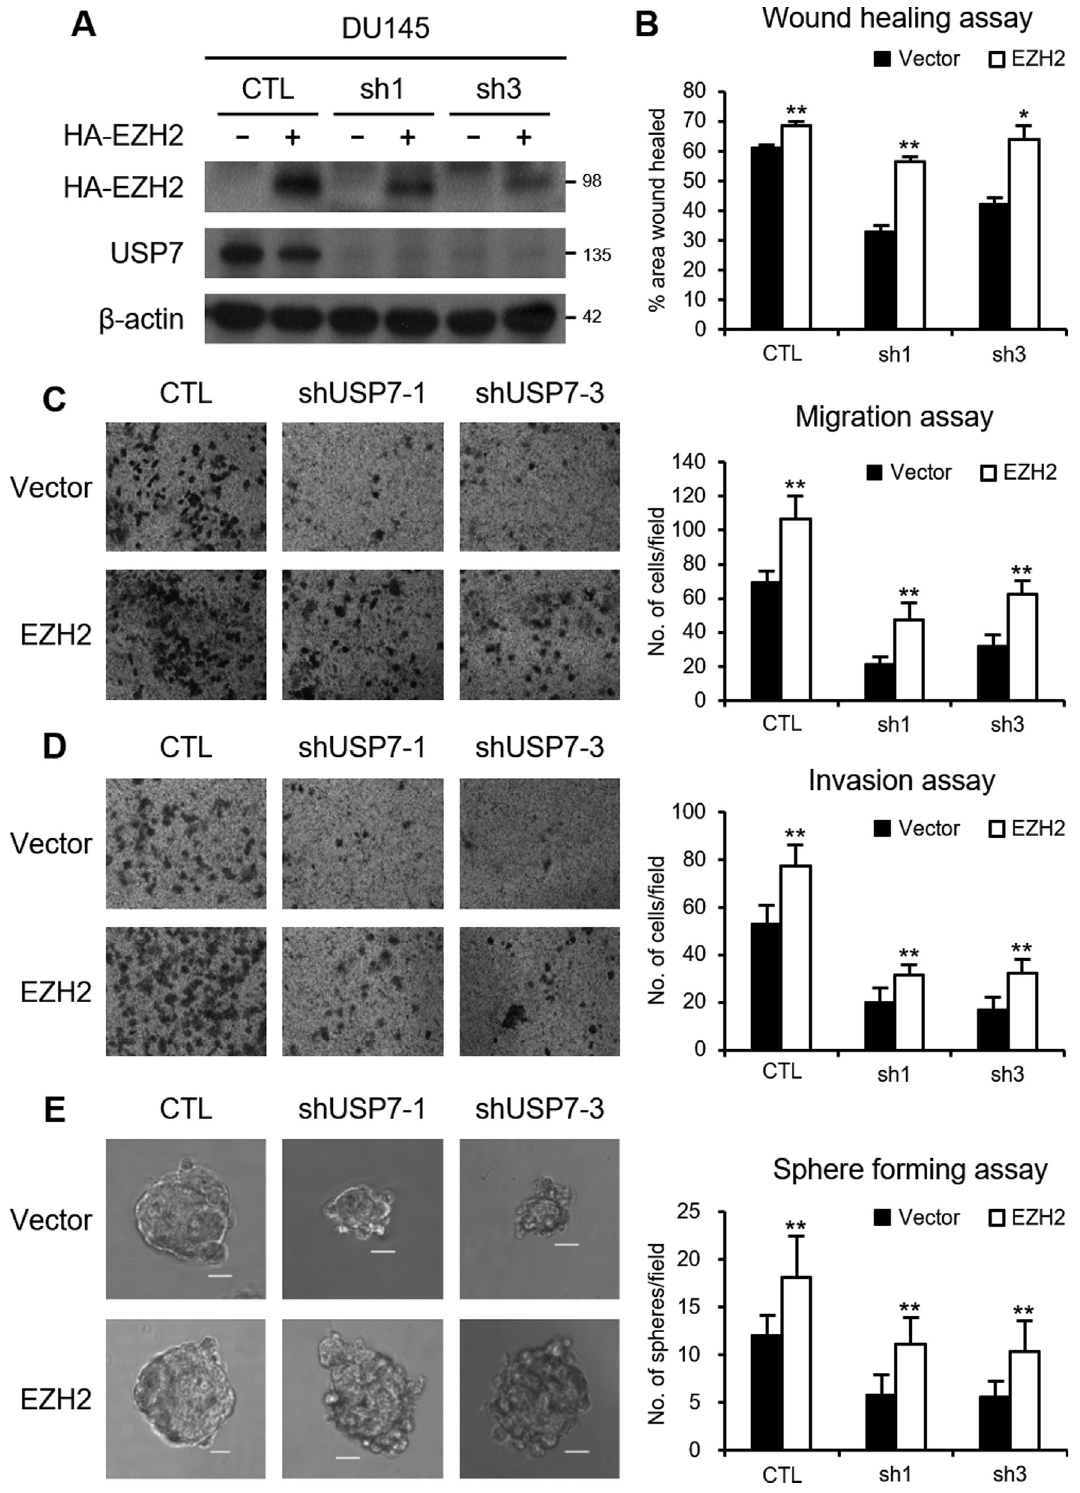
Figure 5 - USP7 promotes the migration and invasion of DU145 cells via EZH2 stabilization. (A) HA-EZH2 was expressed in USP7-knockdown DU145 scellsandcelllysateswereimmunoblottedwithanti-HAoranti-USP7antibody.(B)WoundhealingassaysofUSP7-knockdownDU145stablecellsafter either vector or EZH2 overexpression. (C) Migration assays of USP7-knockdown DU145 stable cells after either vector or EZH2 overexpression. (D) Matrigel invasion assays of USP7-knockdown DU145 stable cells after either vector or EZH2 overexpression. (E) Sphere formation assays of USP7-knockdown DU145 stable cells after either vector or EZH2 overexpression. The figure shows representative images from each cell, and the scale bar corresponds to 100 (cid:2) m. Values are expressed as the mean (cid:6) SD of three independent experiments (B–E). The p value was obtained by Student’s t -test. * p < 0.05, ** p <